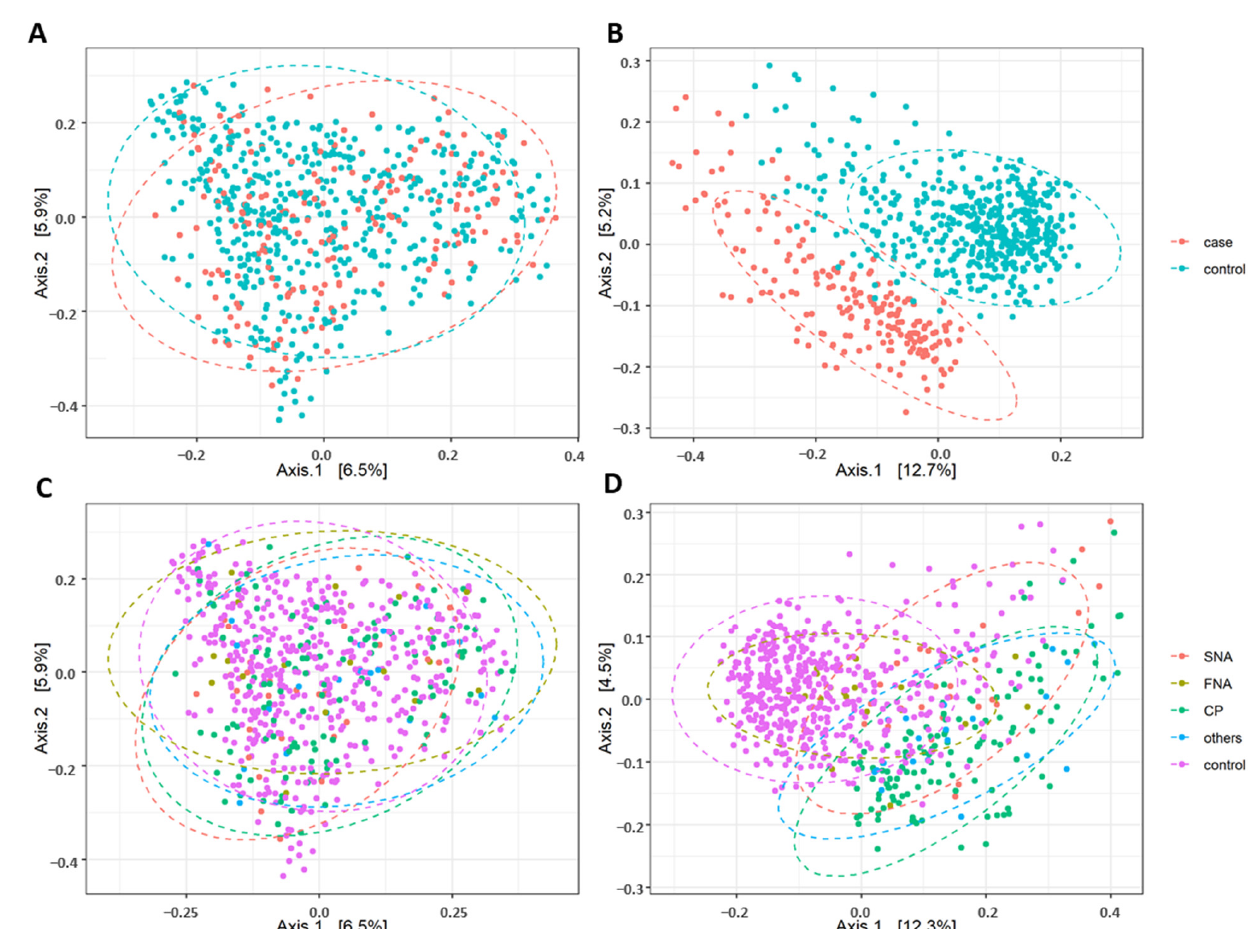
Figure 4. Differences between controls and cases in principal coordinate analysis (PCoA) without confounding factors in ( A ) Bray-Curtis and ( B ) Jaccard beta diversity and between neurological subgroups in ( C ) Bray–Curtis and ( D ) Jaccard beta diversity (permutation analysis of variance (PerMANOVA); all were significantly different with p < 5 × 10 − 2 ). SNA: structural neurological abnormalities; FNA: functional neurological abnormalities; CP: chronic pain and others (=these probands gave information on the presence of neurological symptoms for which the diagnostic work-up was not completed at the time of answering the FoCus questionnaire).